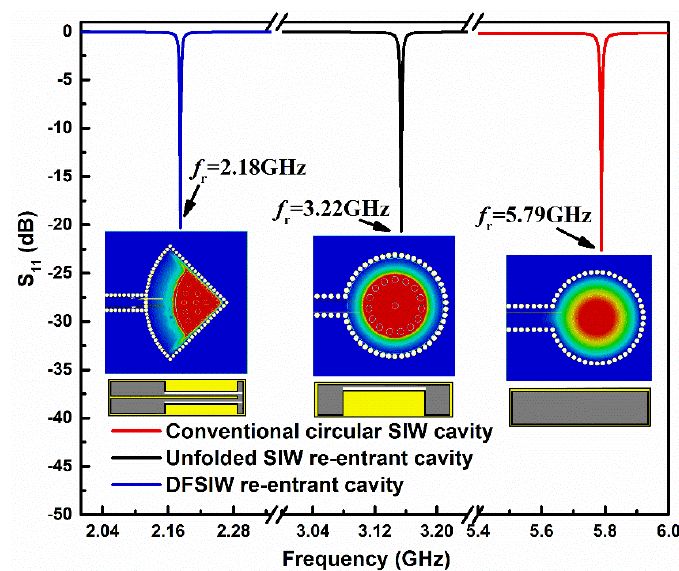
Figure 2. Simulated reflection coefficients S 11 of a conventional circular SIW cavity, an unfolded SIW re-entrant cavity, and the proposed DFSIW re-entrant cavity. Note that the resonant cavity areas of these three cavities were kept identical for a better comparison. The insets are the corresponding electric distributions of these three cavities at resonances.